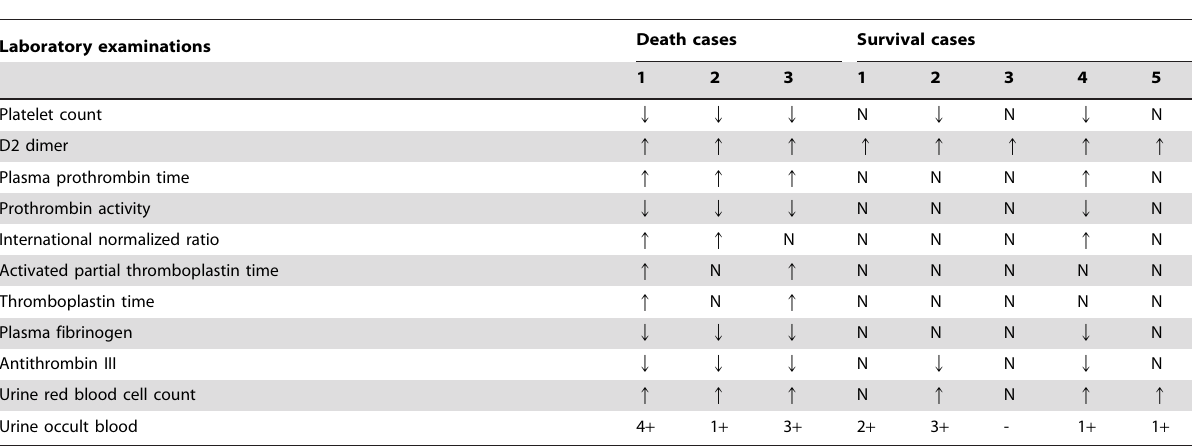
Table 1. Statistical data of laboratory examinations for 8 patients with heat stroke.